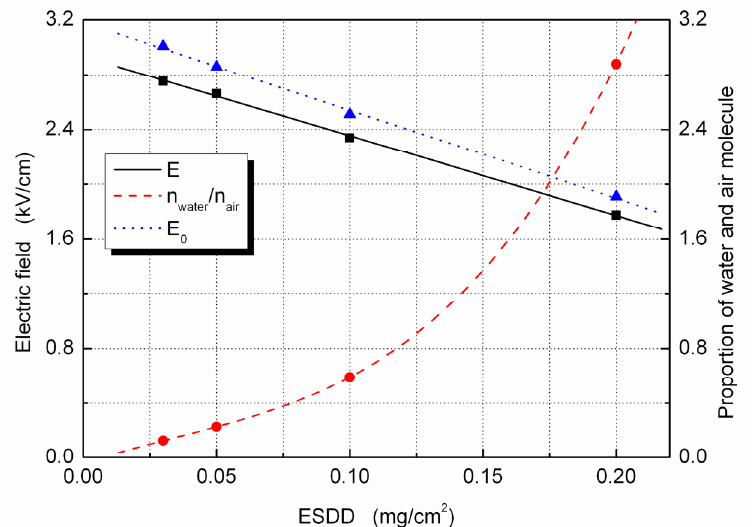
Figure 2. Relationships of the electric field at arc head in the horizontal direction with/without image charge effect ( E / E / n with the n water air